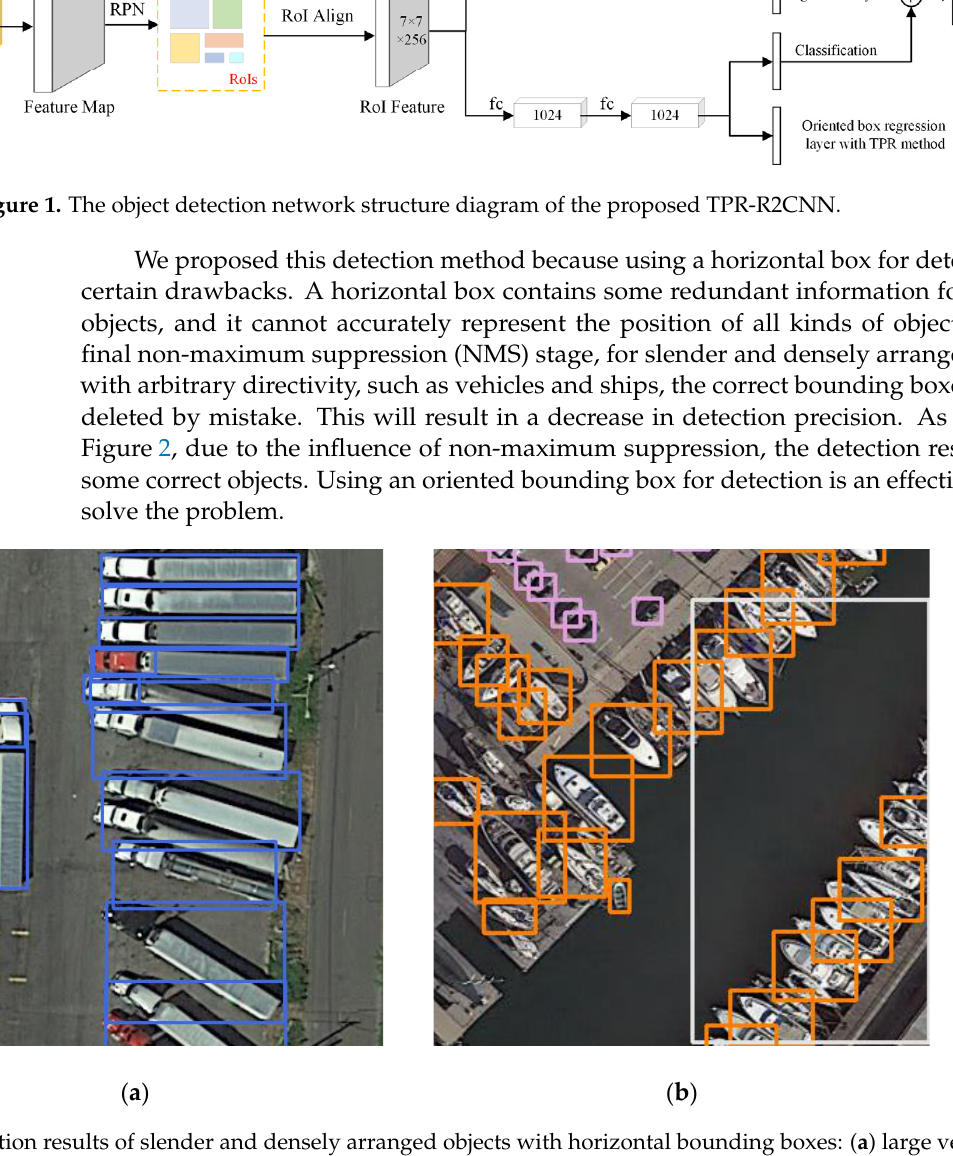
Figure 2. The detection results of slender and densely arranged objects with horizontal bounding boxes: ( a ) large vehicle and ( b ) ship, small vehicle.